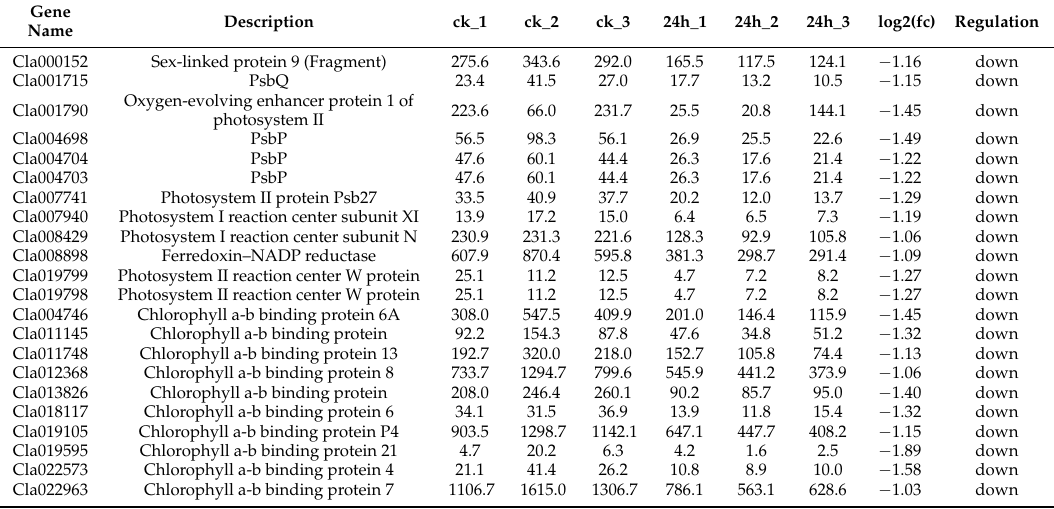
Table 2. Differentially expressed genes in watermelon leaves involved in